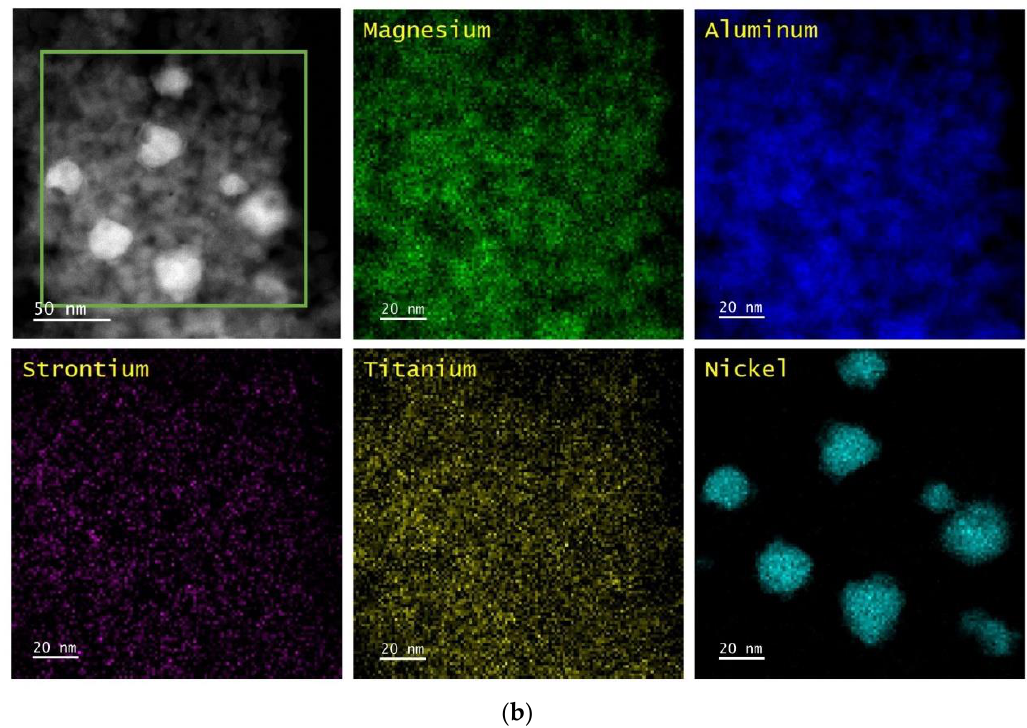
Figure 2. ( a ) Representative STEM results for Ni/SrTiO 3 /MgAl 2 O 4 after 1073 K oxidation followed by 773 K reduction with EDS maps of corresponding elements. ( b ) Representative STEM results for Ni/SrTiO 3 /MgAl 2 O 4 after 1073 K oxidation followed by 1073 K reduction with EDS maps of corresponding elements.